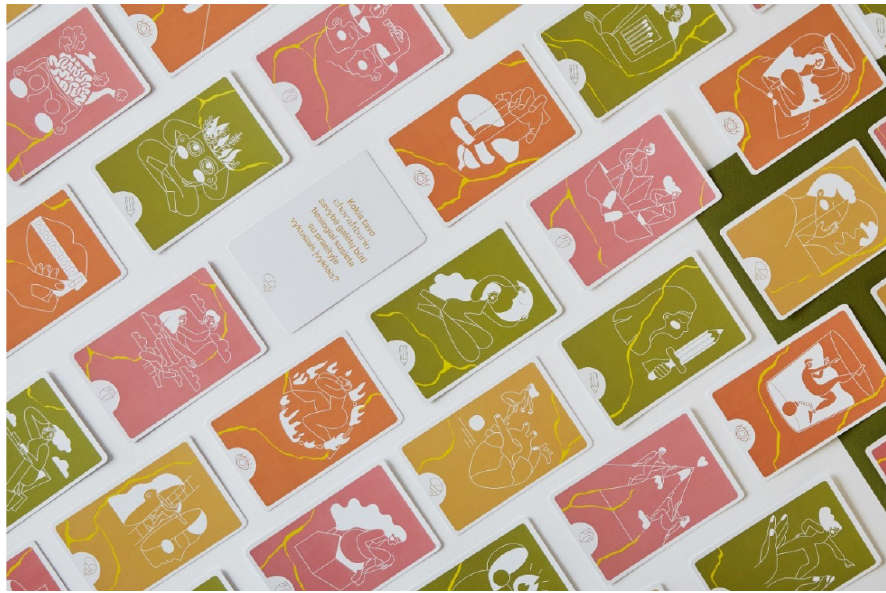
Figure 3. The illustrations made for a board game cards, using the automatic sketching technique (source: Liebutė,